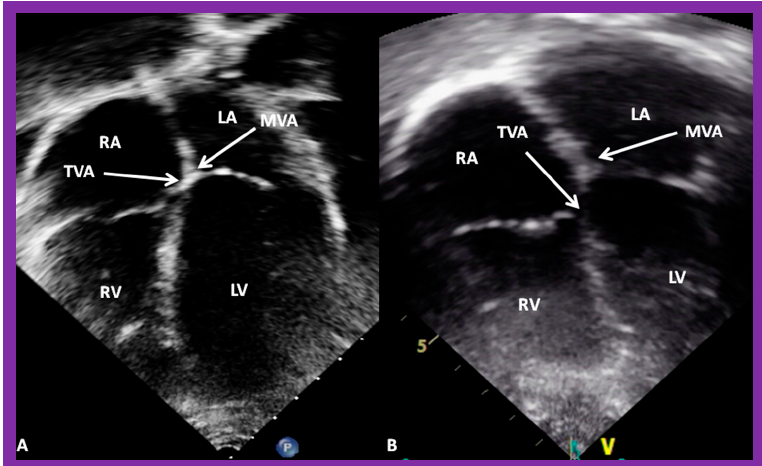
Figure 38. ( A , B ). Echo images in apical four-chamber views of 2 children with a normal interventricular relationship. A superior level of mitral valve attachment (MVA) relative to attachment of the tricuspid valve (TVA) is seen in both children. Left atrium (LA), left ventricle (LV), right atrium (RA), and right ventricle RV are labeled. Replicated from reference [4].